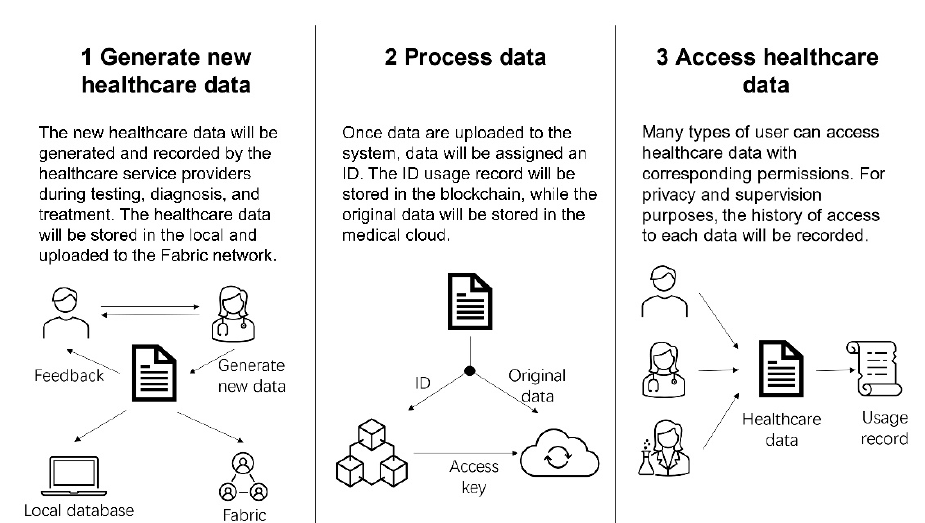
Figure 1. System functions in the proposed framework.